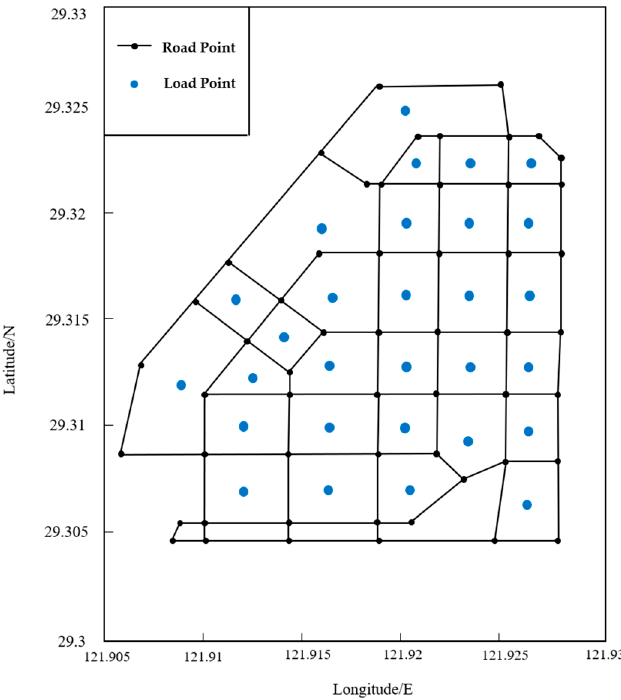
Figure 4. Graph model of the studying area.